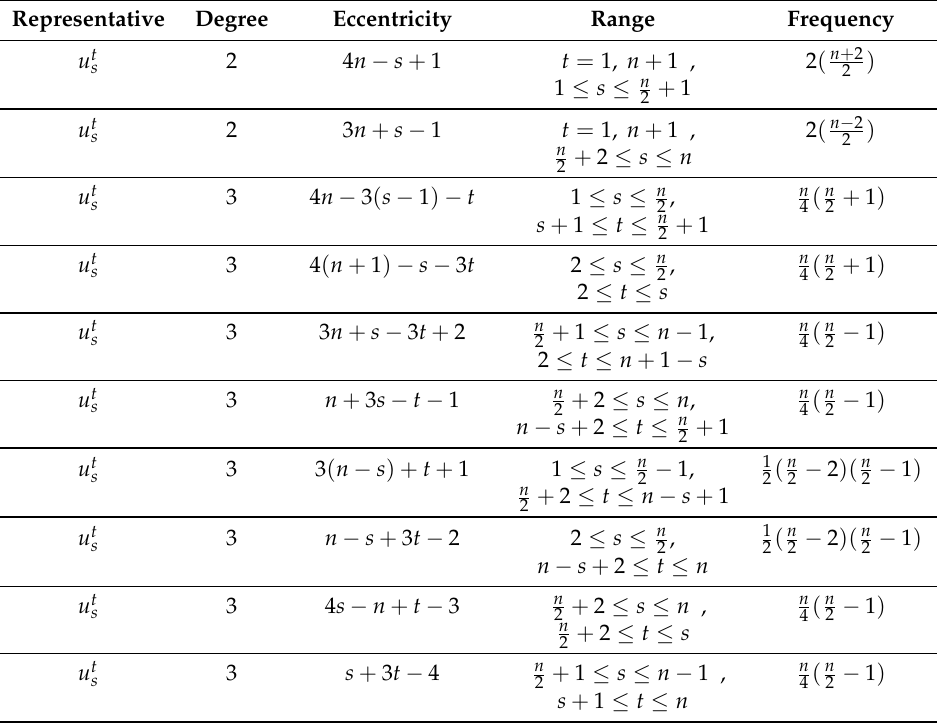
Table 1. Partition of vertices of the type u t s of O m n based on degree and eccentricity of each vertex when n ≡ 0 ( mod 2 )